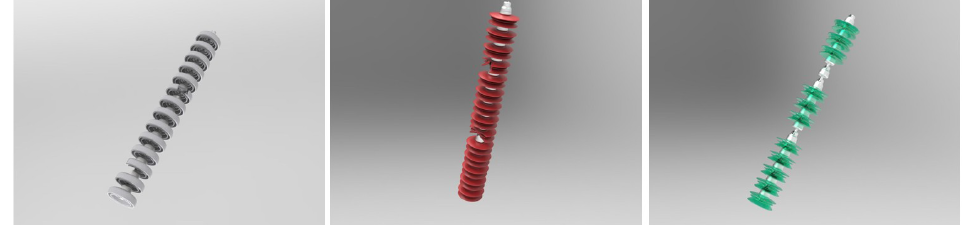
Figure 4. Artificial defect sample images of insulators (glass, ceramic and composite